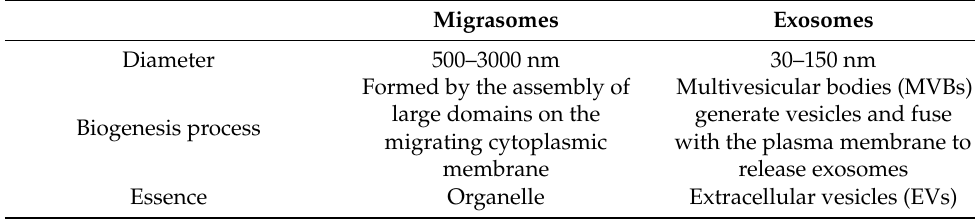
Table 1. Comparison of migrasomes and